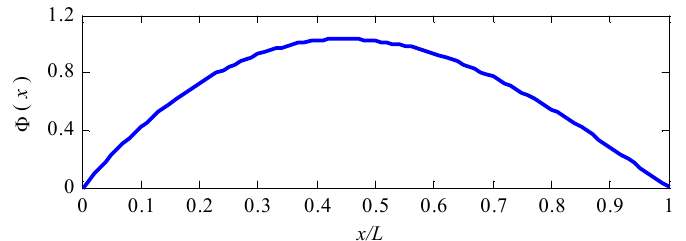
Figure 4. The first derivation of the clamped sliding beam function.